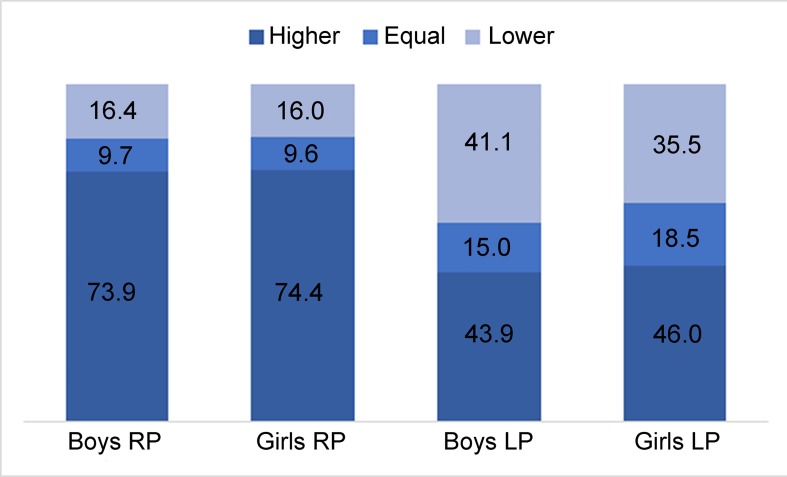
Percentage of children that scored higher, equal, or lower with their preferred hand compared with their non-preferred hand, according to hand preference and gender.